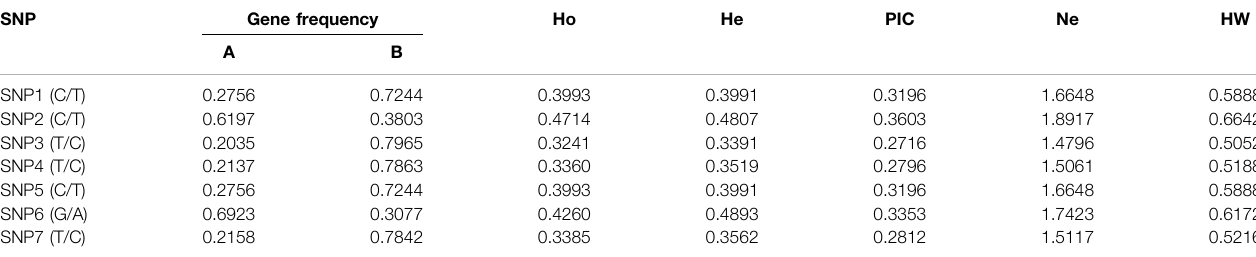
TABLE 4 | Population genetics analyses of SSTR5 of in Hulun Buir sheep a